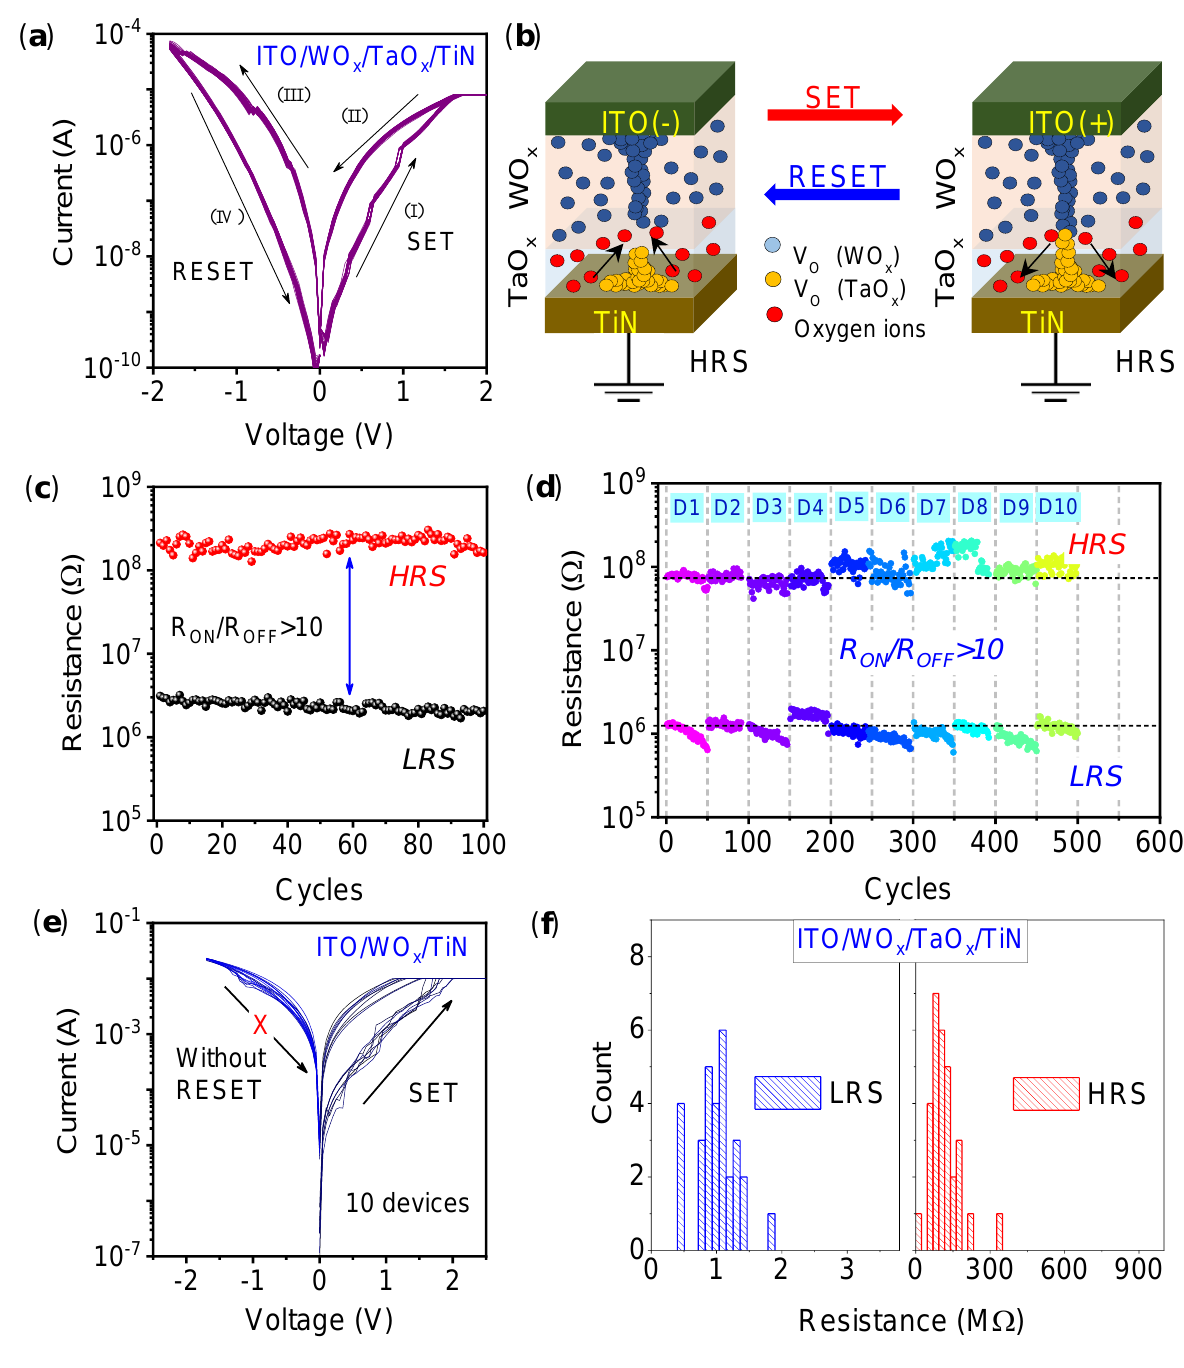
Figure 1. ( a ) Bipolar resistive switching characteristics of the ITO/WO x /TaO x /TiN device. ( b ) Schematic description of the SET and RESET process showing the formation and annihilation of conductive filament. ( c ) DC endurance characteristics with 100 stable cycles. ( d ) Multiple devices show promising device-to-device reliability with a uniform R ON /R OFF ratio. ( e ) I–V characteristics of the ITO/WO x /TiN device at the current compliance of 10 mA without RESET characteristics. ( f ) The distribution histogram of HRS and LRS for 30 ITO/WO x /TaO x /TiN memristors.